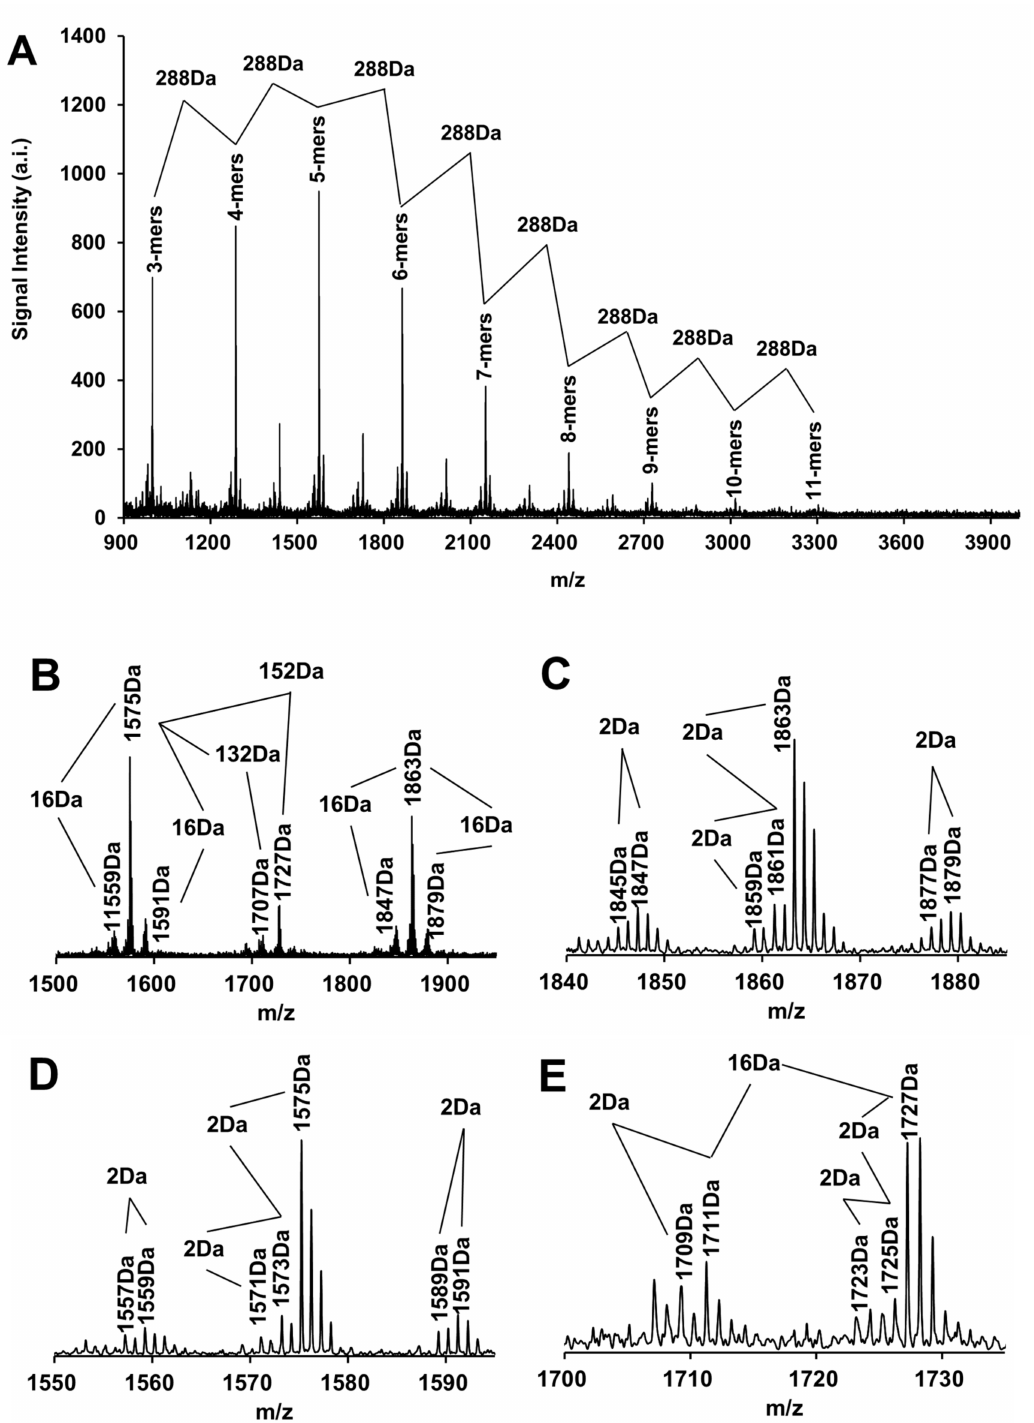
Figure 5. The MALDI-TOF MS spectrum of the 70% acetone eluent of the rhizome of F. dibotrys (( A ) represents the spectrum of the ion peak in the range of m / z 900–4000, while ( B – E ) represent the locally amplified